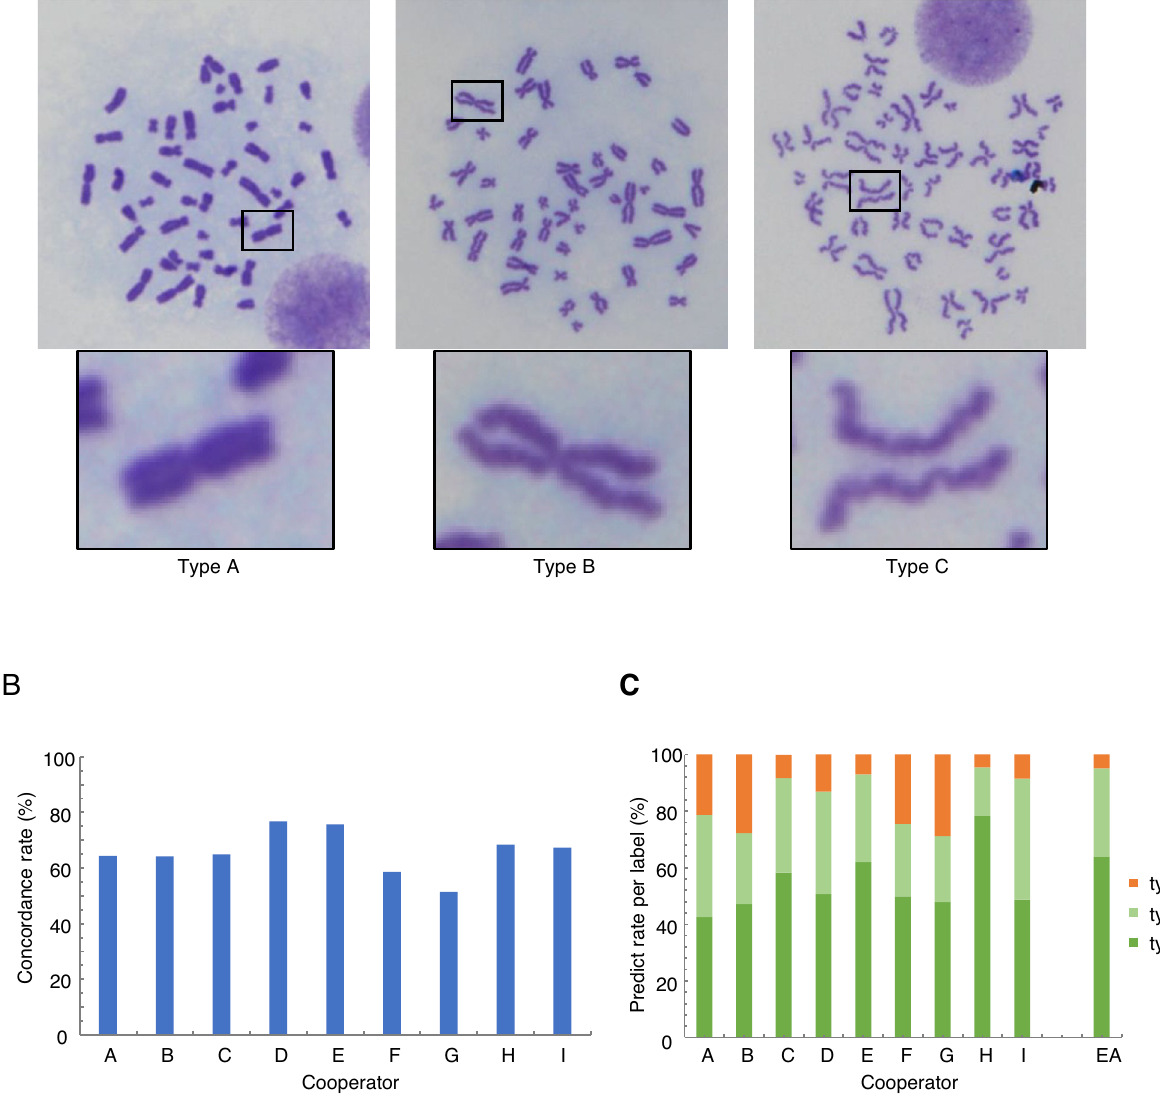
Figure 1. Classification of chromosome types of WT TK6 cells. ( A ) Representative images for each label. ( B ) Concordance rates between EA and answers from each cooperator. ( C ) Distribution of each type of